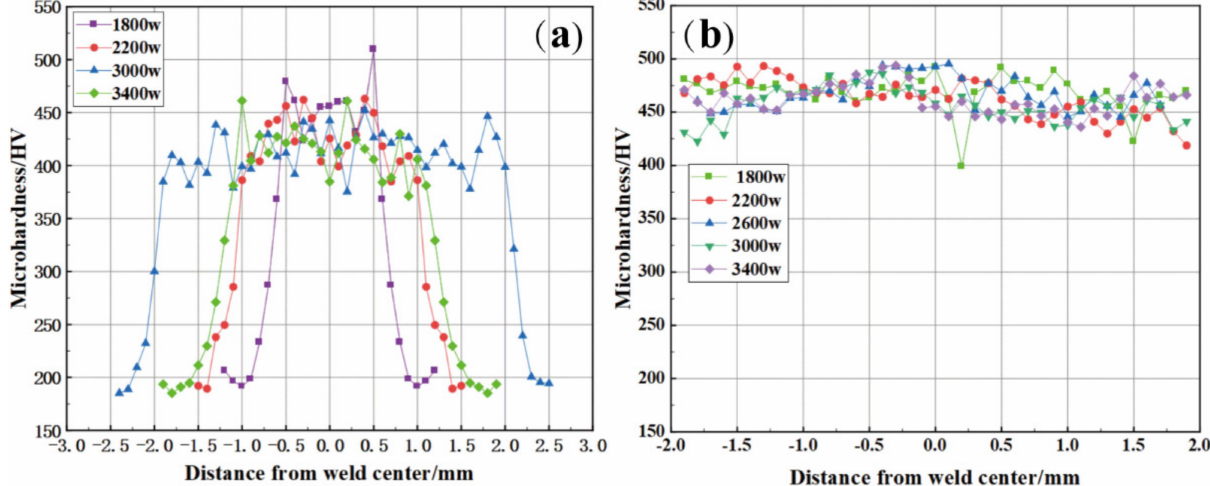
Figure 10. Microhardness of joint under different laser power: ( a ) before quenching; ( b ) after quenching.